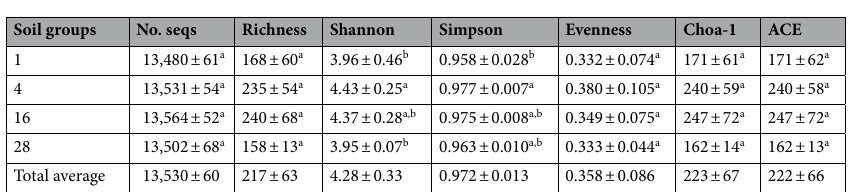
Table 1. Bacterial diversity indices and richness of different soil groups. Values reported as mean ± standard deviation. The superscript letters ‘ a ’ and ‘ b ’ represent statistical differences ( p < 0.05).